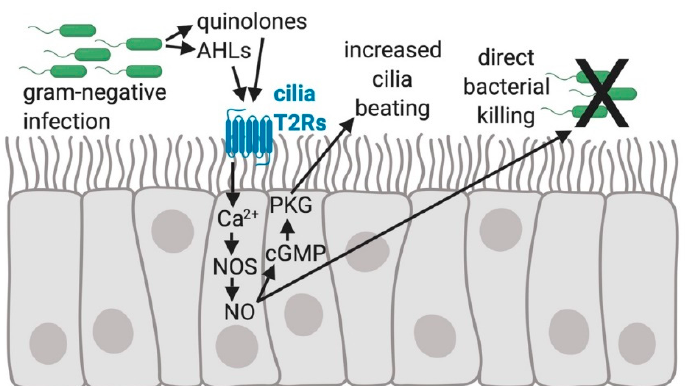
Figure 2. The regulation of human sinonasal epithelial innate immunity by bitter taste receptors (T2Rs). Quinolones and Acyl-homoserine lactones (AHLs) made by gram-negative bacteria, including Pseudomonas aeruginosa , activate the T2Rs expressed in human sinonasal cilia, resulting in an elevation of intracellular calcium (Ca 2 + ) that stimulates nitric oxide (NO) production by activating nitric oxide synthase (NOS) [44]. NO activates guanylyl cyclase to convert GTP to cyclic-GMP (cGMP), which binds to and increases the activity of protein kinase G (PKG). PKG can phosphorylate ciliary proteins [61,62] causing increased ciliary beat frequency that speeds up mucociliary transport [42,44]. NO di ff usion into the airway mucus and surface liquid is bactericidal and possibly damaging to viral or fungal pathogens